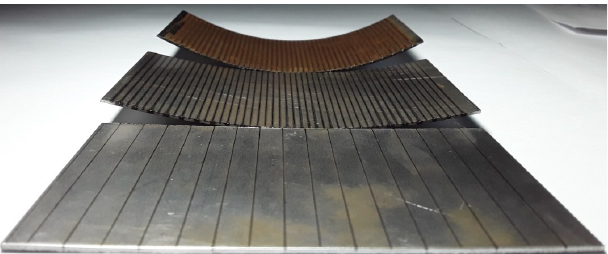
Figure 1. Some of the laser-formed cylindrical surfaces from primary sheets with dimensions of 1 mm (thickness) × 100 mm (length) × 60 mm (width), obtained from different input parameters.